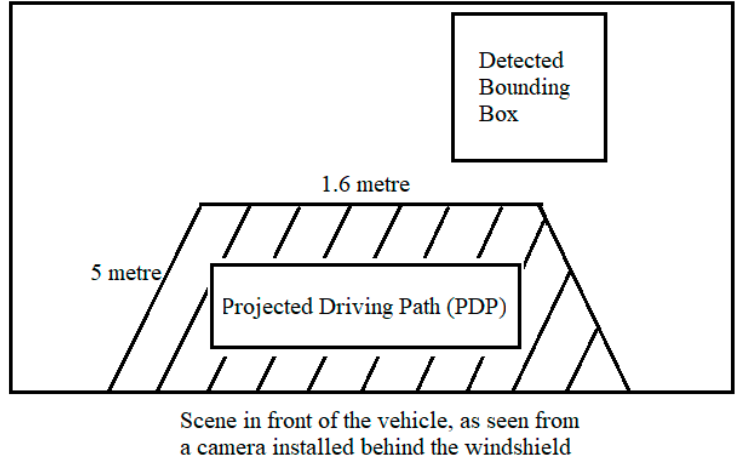
Figure 16. Safe scenario for EBA.